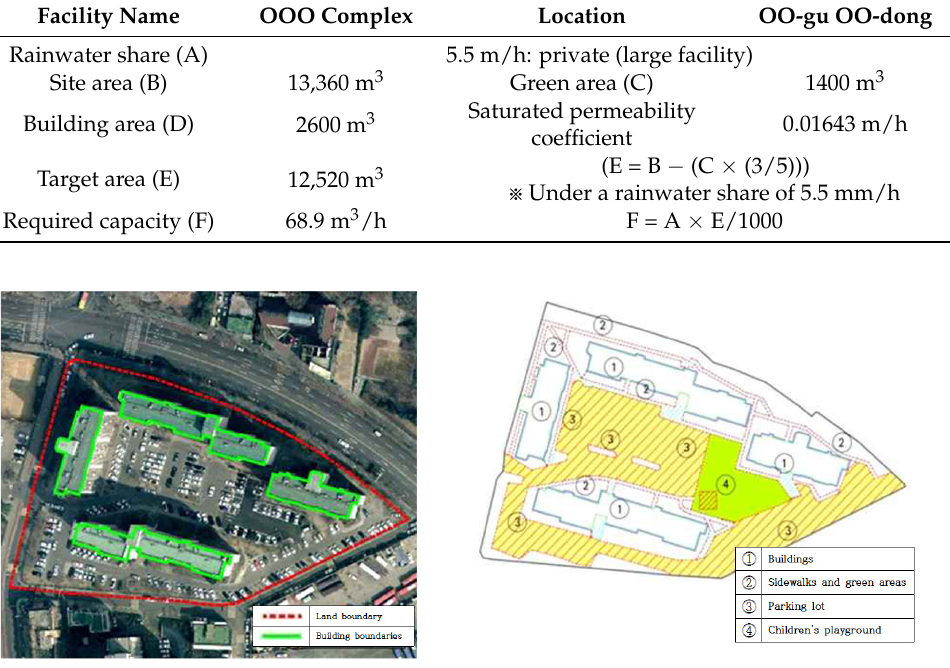
Table 12. Design water quantity of the existing system and eco-friendly rainwater detention system.